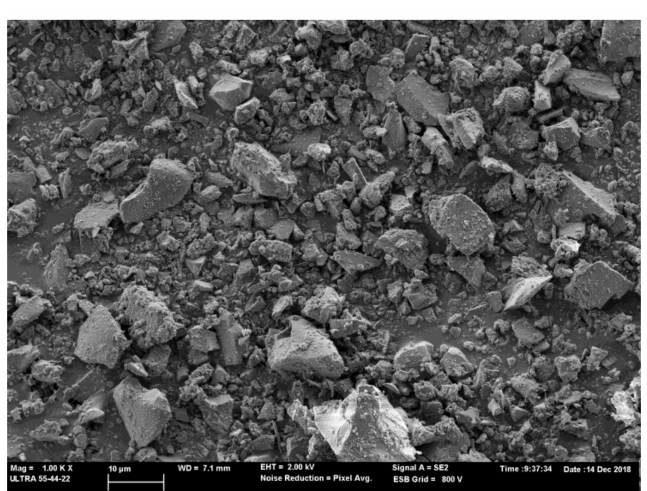
Figure 2. XRD di ff ractogram of BFS.